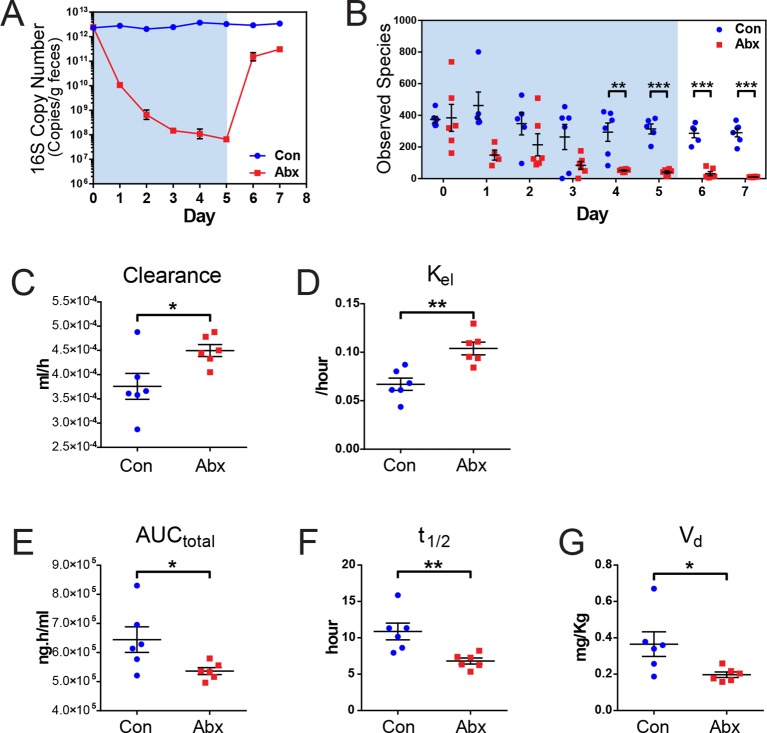
Microbiota-depletion with antibiotics alters the pharmacokinetics of indomethacin in mice.Mice were subjected to control water (Con) or antibiotic cocktail (Abx, neomycin and vancomycin) for 5 days (blue-shaded area). Upon the cessation of 5-day treatment, mice were administered by gavage with 10 mg/kg indomethacin. Plasma was collected sequentially for pharmacokinetic analysis. Fecal microbiota compositions over time were analyzed using 16S rRNA gene profiling. (A) Longitudinal analysis of 16S rRNA gene copies per gram of feces reveals a significant reduction in microbial load in Abx group (red). (B) Longitudinal analysis of observed species reveals decreased microbial richness in Abx group (red). **p<0.01, ***p<0.001 by multiple t test, FDR corrected. N=4–6/group. Mean ± S.E.M. shown. In antibiotic-treated mice (red), indomethacin has increased oral clearance (C) and elimination rate constant (Kel) (D), as well as decreased area under the curve (AUCtotal) (E), half-life (t1/2) (F), and apparent volume of distribution (Vd) (G). *p<0.05, **p<0.01 by Mann-Whitney test. N=6/group. Mean ± S.E.M. shown.